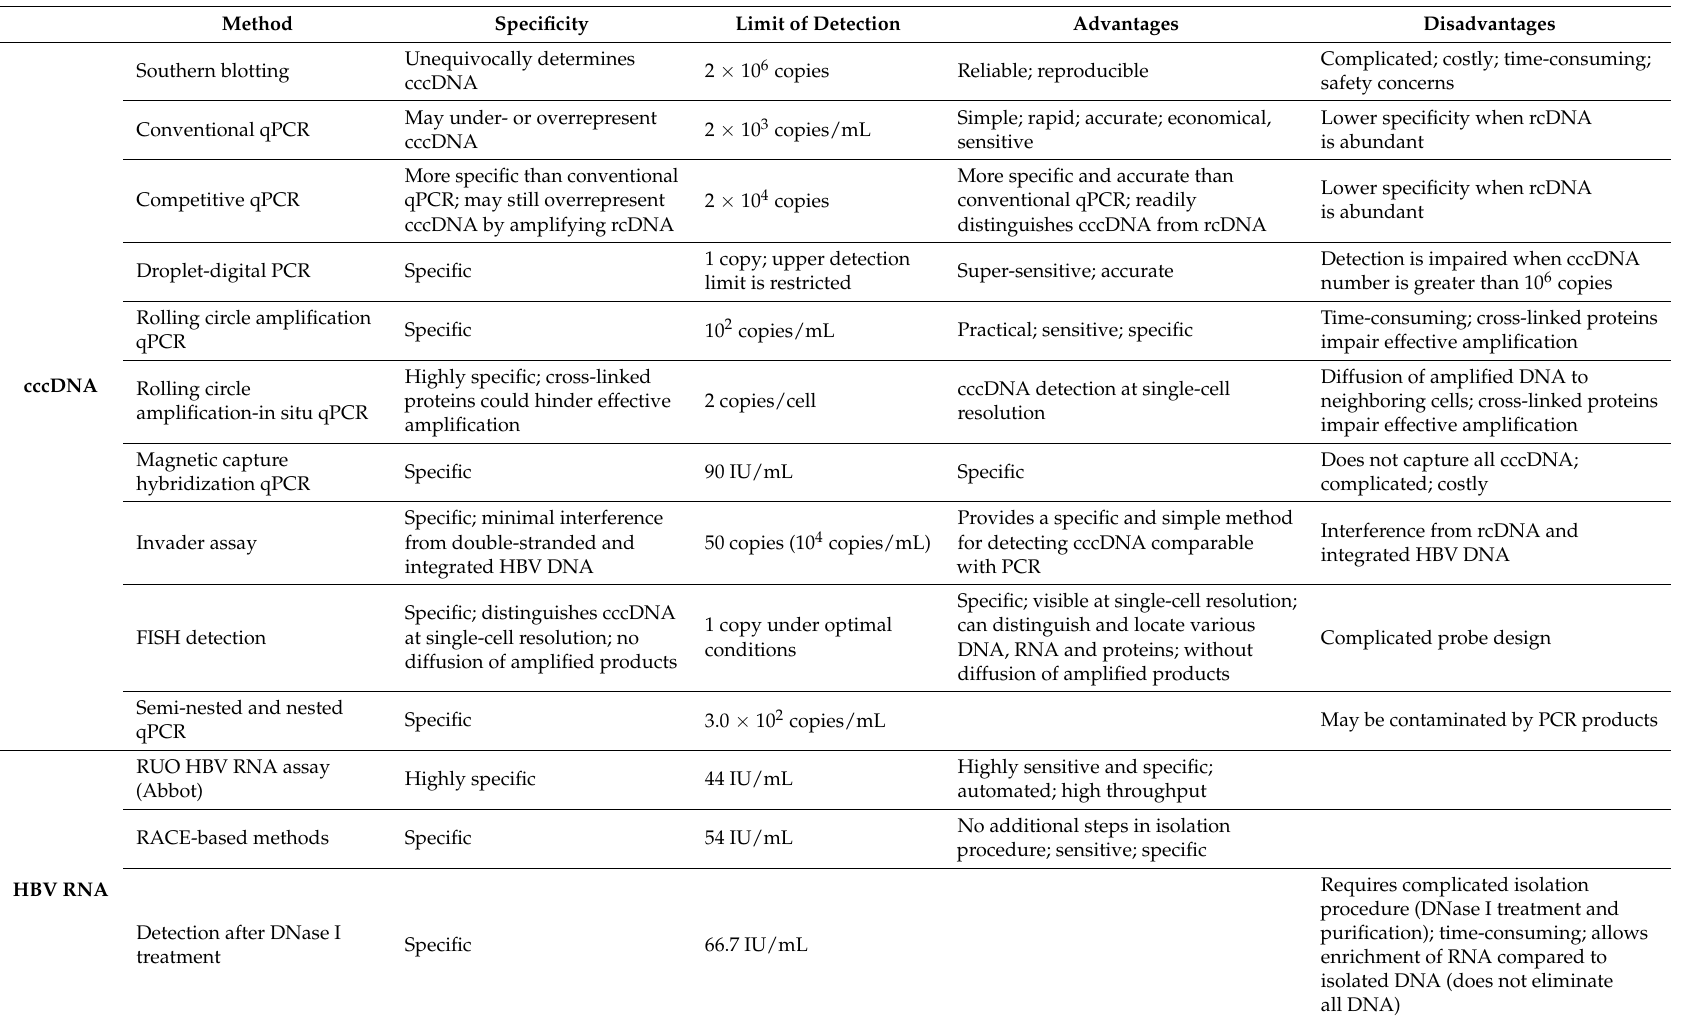
Table 5. Comparison of modern methods to detect and quantify HBV cccDNA and